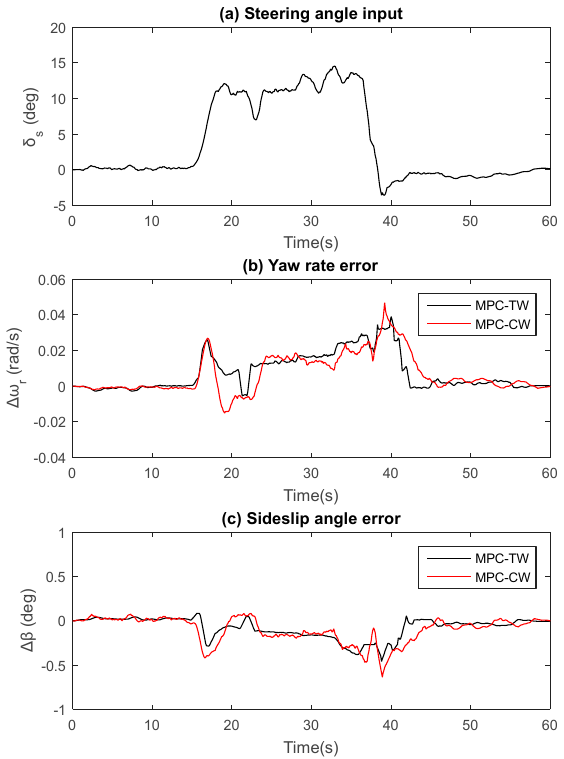
Figure 7. Yaw rate error and side-slip angle error.